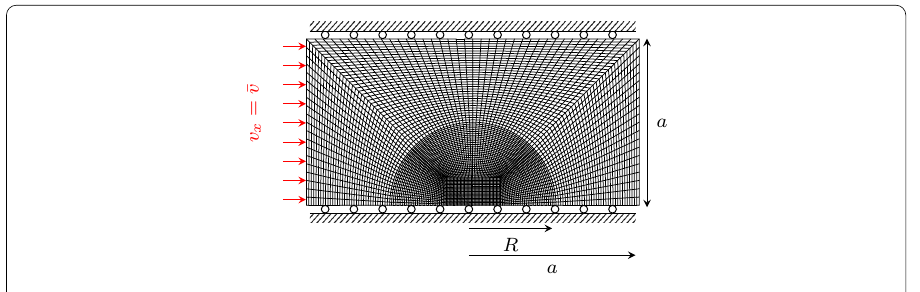
Fig. 18 Half of a heterogeneous volume that consists of a circular inclusion embedded in a matrix, suddenly loaded then unloaded after a time t u on its left side by a prescribed velocity ¯ v